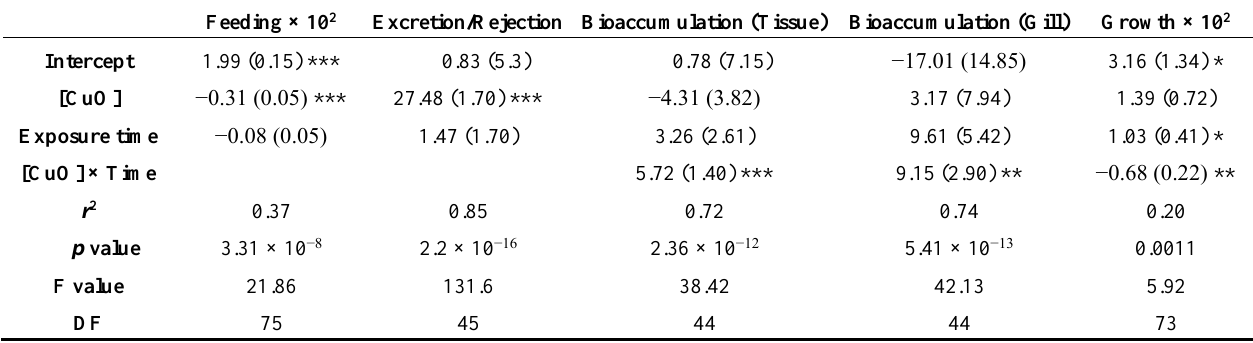
Table 1. Multiple OLS regressions examining the impact of CuO ENP exposure on feeding, Cu excretion, accumulation, and